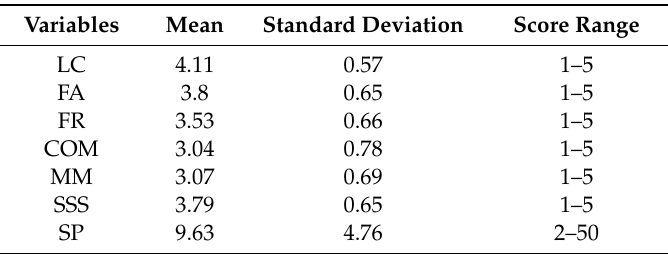
Table 2. Descriptive statistics of all construct